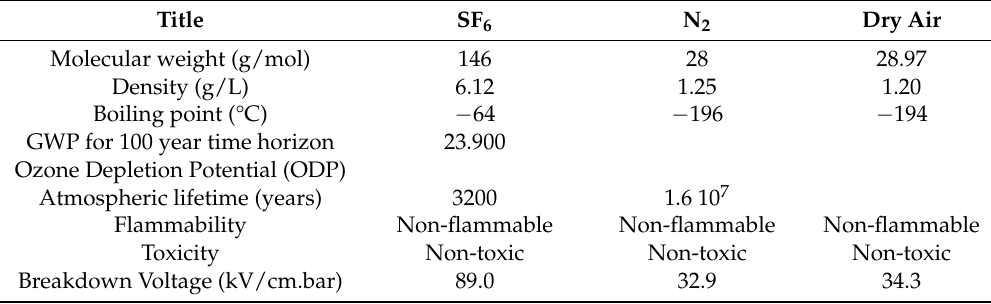
Table 2. Physical and environmental properties of SF 6 , N 2 , and dry air [13–16].